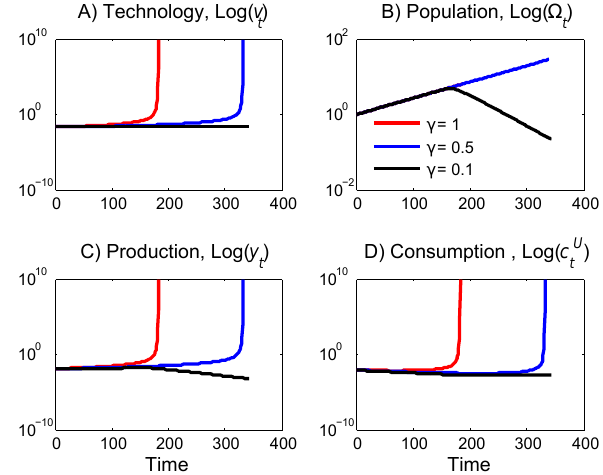
Figure 5. The co-evolution of technology, population, produc- tion and consumption per capita under a modest rate of success ( γ = 0.10, 0.01) and no technological change ( γ = 0.00). The pop- ulation growth rate threshold η = 0.25. No randomness in the tech- nological rate of success is assumed, i.e., γ = γ .